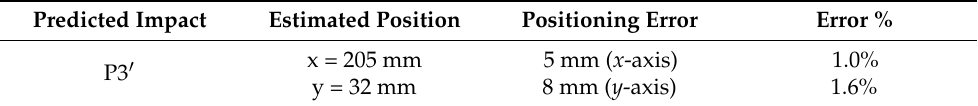
Table 4. Estimated impact position obtained for impact P3 (cid:48) with coordinates x i = 200 mm, y i = 40 mm. Predicted